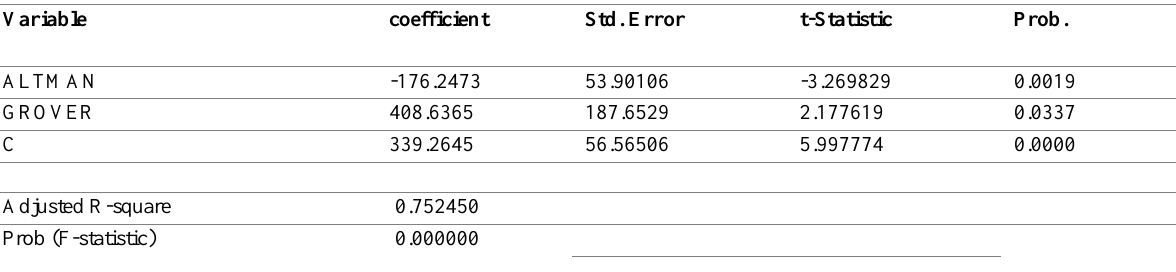
Table 9: Fixed effect model